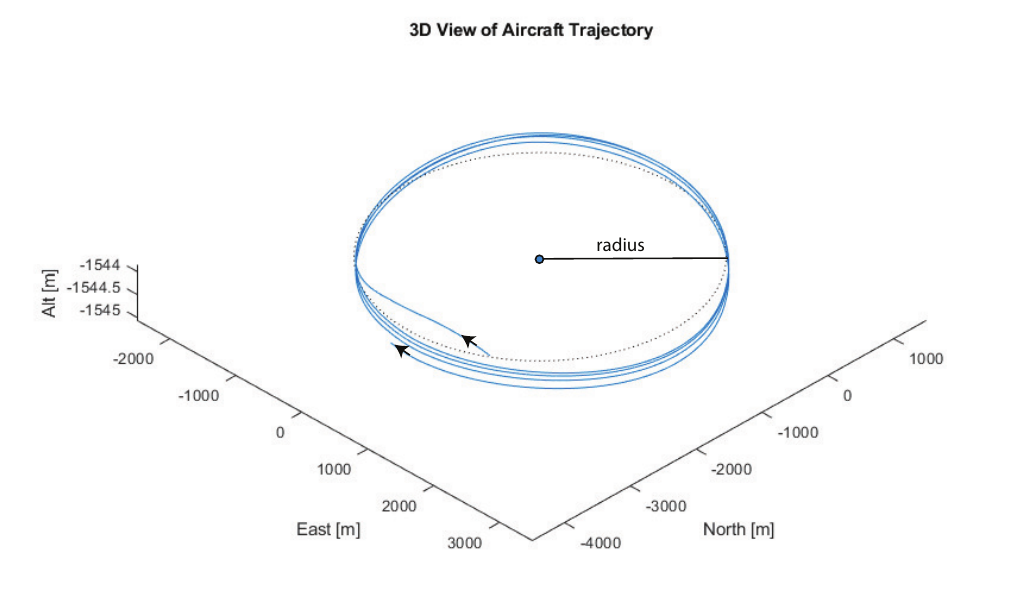
Figure 5. Simulated 3D unmanned aircraft systems (UAS) flight path (solid blue line) along with a 2D perfect circle (dotted black line). The 2D circle is at a constant altitude, while the 3D UAS flight tracks the 850 mb isosurface. The vertical dimension is shown highly